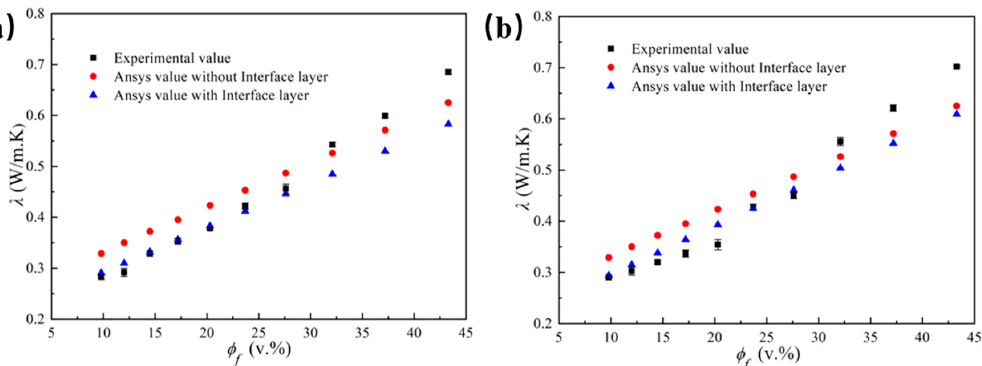
Figure 8. The simulation and experiment results of thermal conductivity for LLDPE/Al 2 O 3 compo- sites with different Al 2 O 3 diameters versus volume fractions of Al 2 O 3 particles: ( a ) for 5 μ m; ( b ) for 40 μ m.